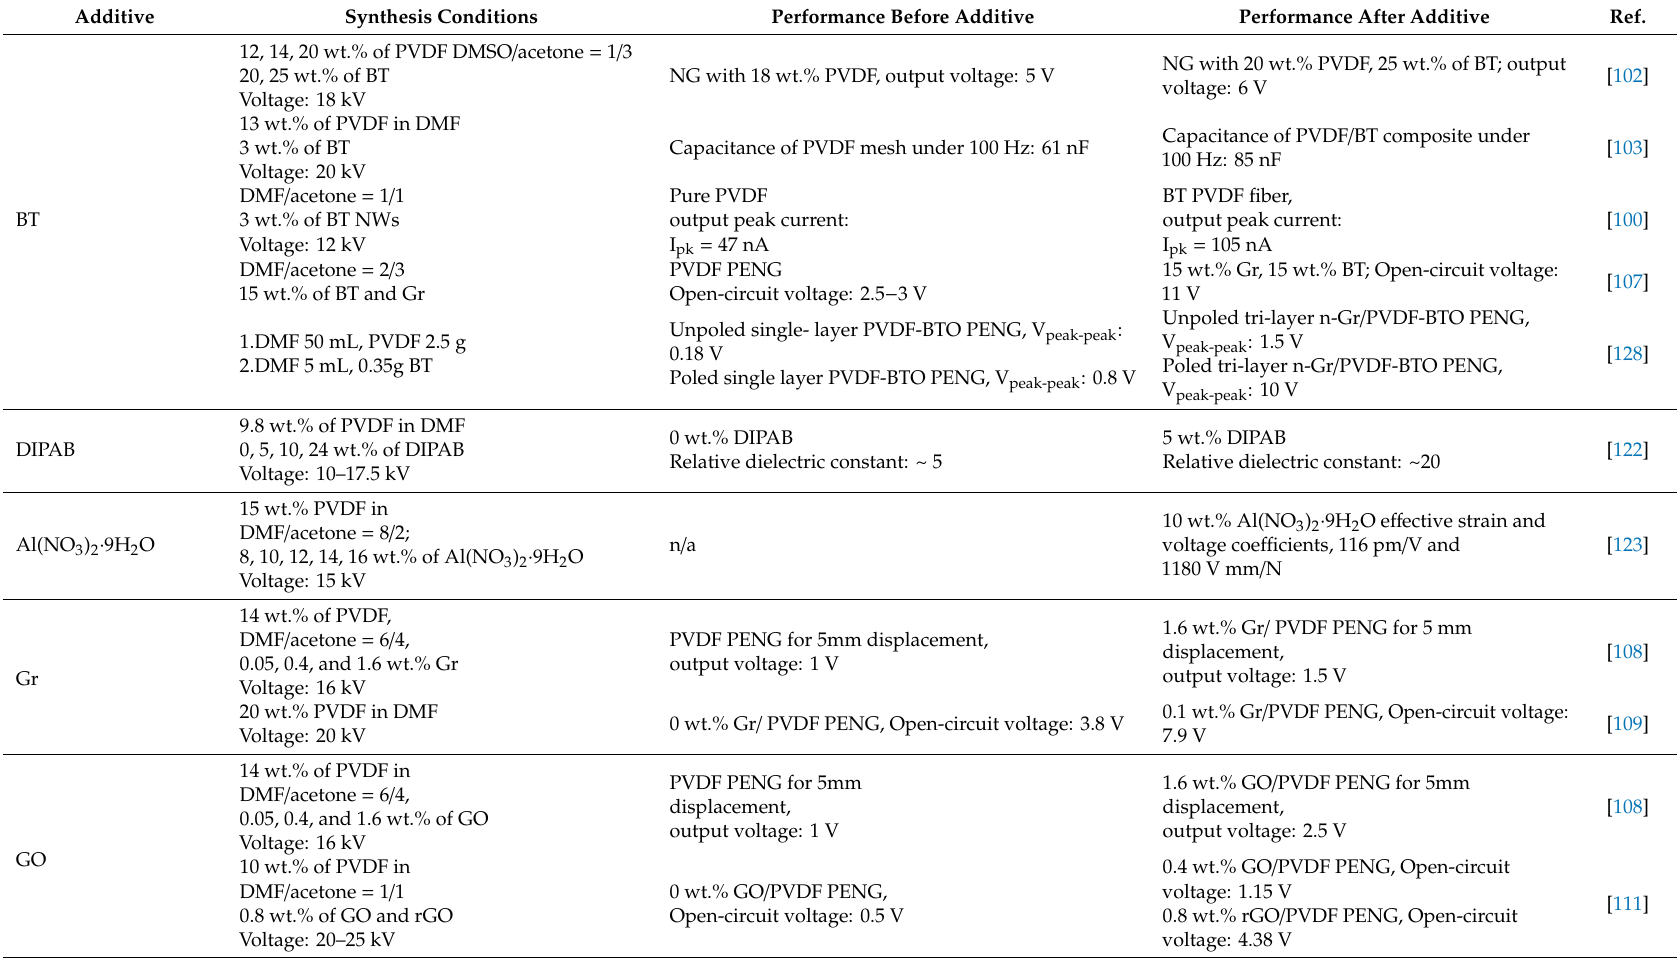
Table 5. Summary of additives used in electrospun